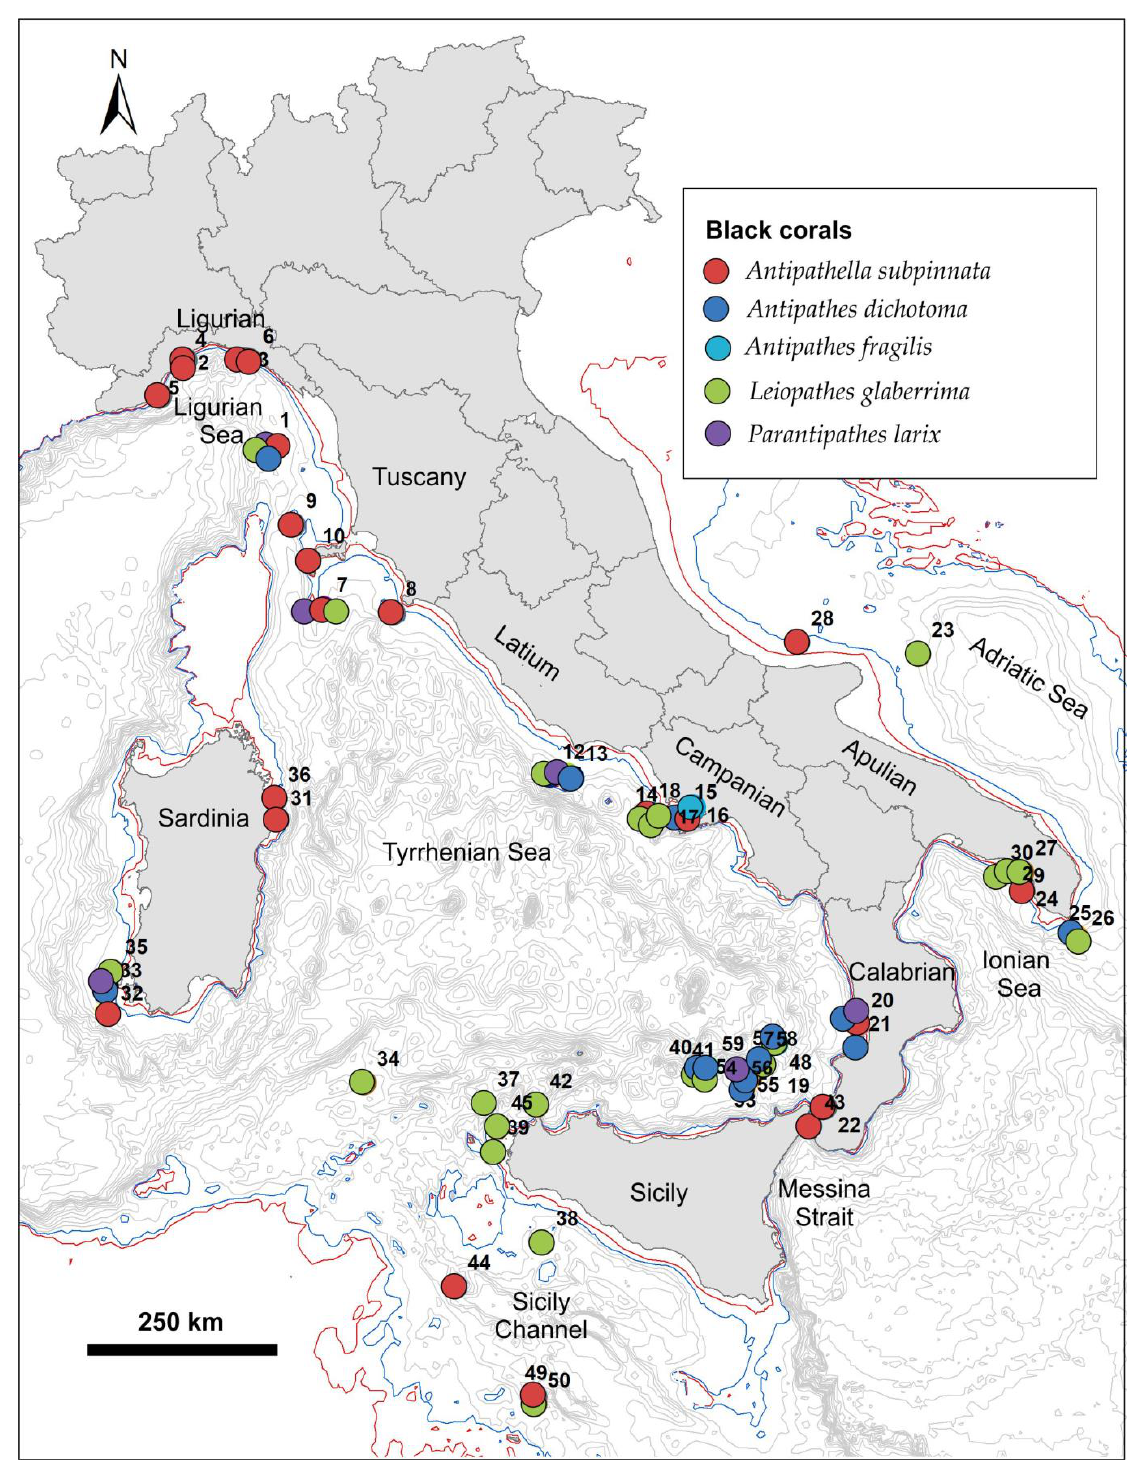
Figure 1. Distribution map of black corals in the Italian seas (red lines: 50-m isobaths; blue lines: 100-m isobaths; grey lines: isobaths of each 200 m interval). Number codes refer to the ID codes reported in Table 1.